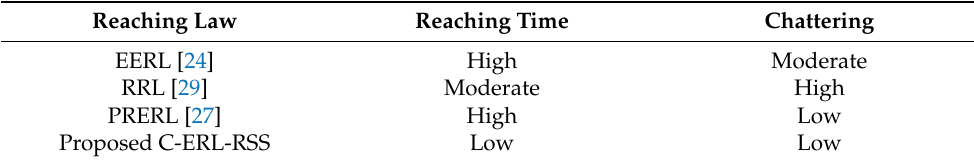
Table 2. Reaching law behavior in terms of the reaching time and chattering. Reaching Law Reaching Time Chattering EERL [24] High Moderate RRL [29] Moderate High PRERL [27] High Low Proposed C-ERL-RSS Low